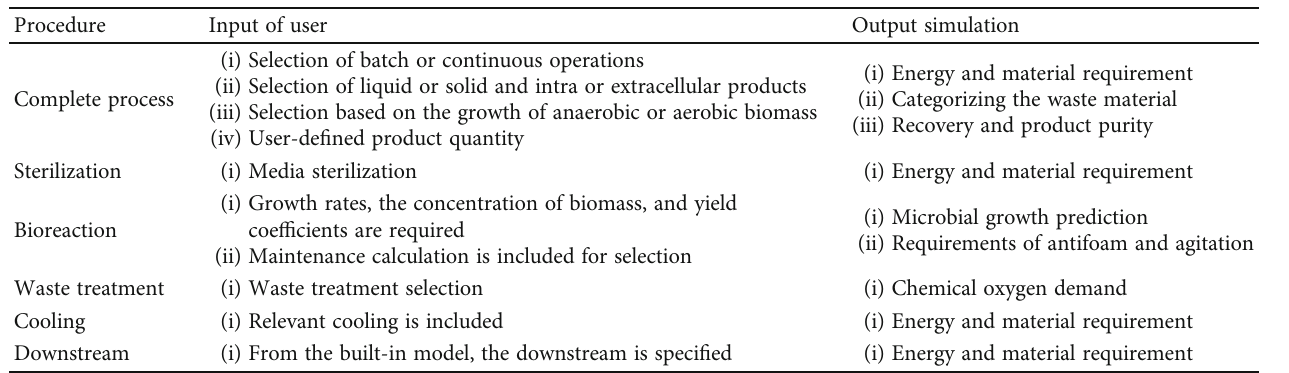
Figure 4: General Process Flow Diagram. Table 2: Input requirement and simulation.